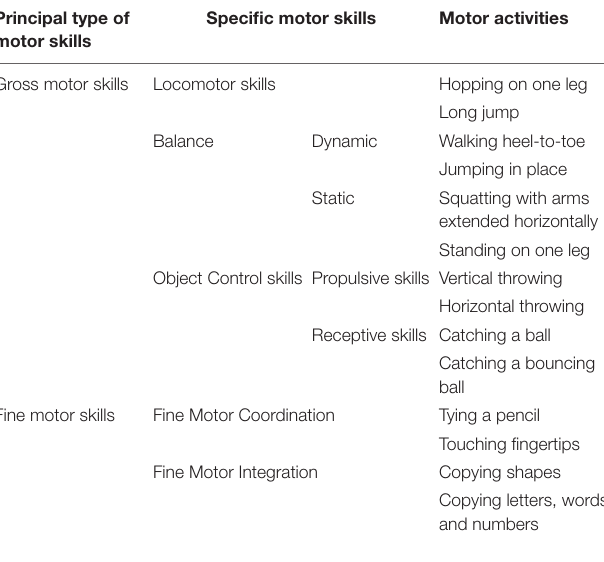
TABLE 1 | Motor activities designed to observe the distinct specific motor